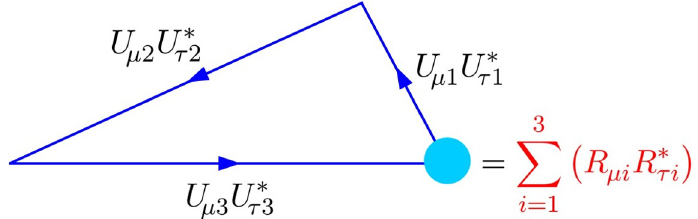
Figure 2 . An illustration of the unitarity polygon defined by the ( µ, τ ) -associated orthogonality condition in the complex plane, where the effective vertex in sky blue denotes small corrections of the active-sterile flavor mixing effects to the three-flavor unitarity triangle in the seesaw